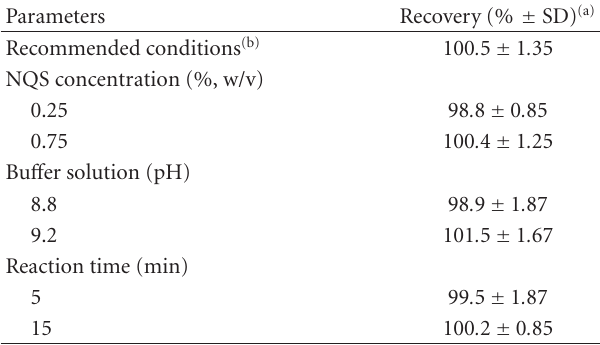
Table 4: Influence of small variations in the assay conditions on the analytical performance of the proposed spectrophotometric method for determination of PRX using NQS